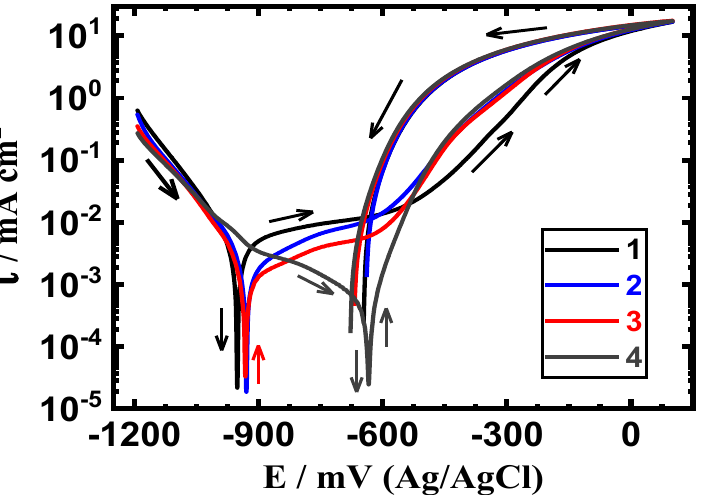
Figure 6. CPP curves for iron after 1 h immersion in (1) 3.5% NaCl solutions in the absence and presence of (2) 5 × 10 −5 M HAO, (3) 1 × 10 −4 M HAO, and (4) 5 × 10 −4 M HAO.